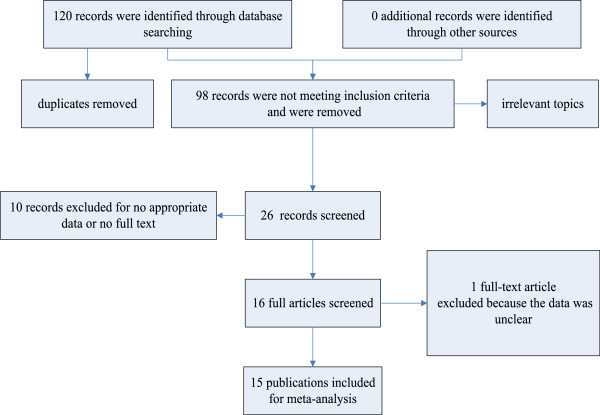
Flow chart of eligible study identification.